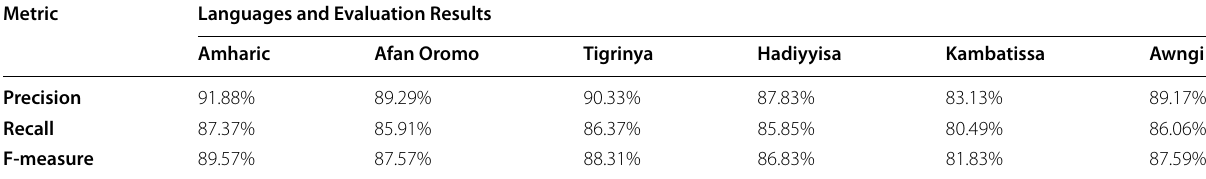
Table 2 Precision, recall, and f-measure results of the model